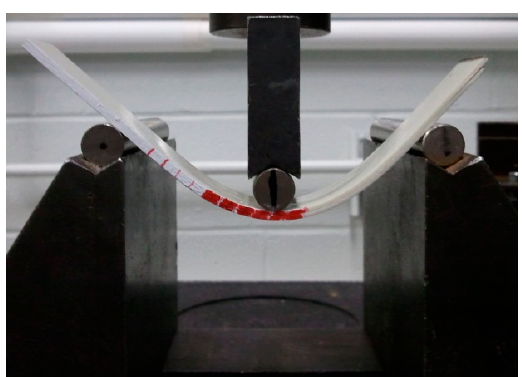
Figure 1. Experimental setup of end-notched flexure (ENF) testing.